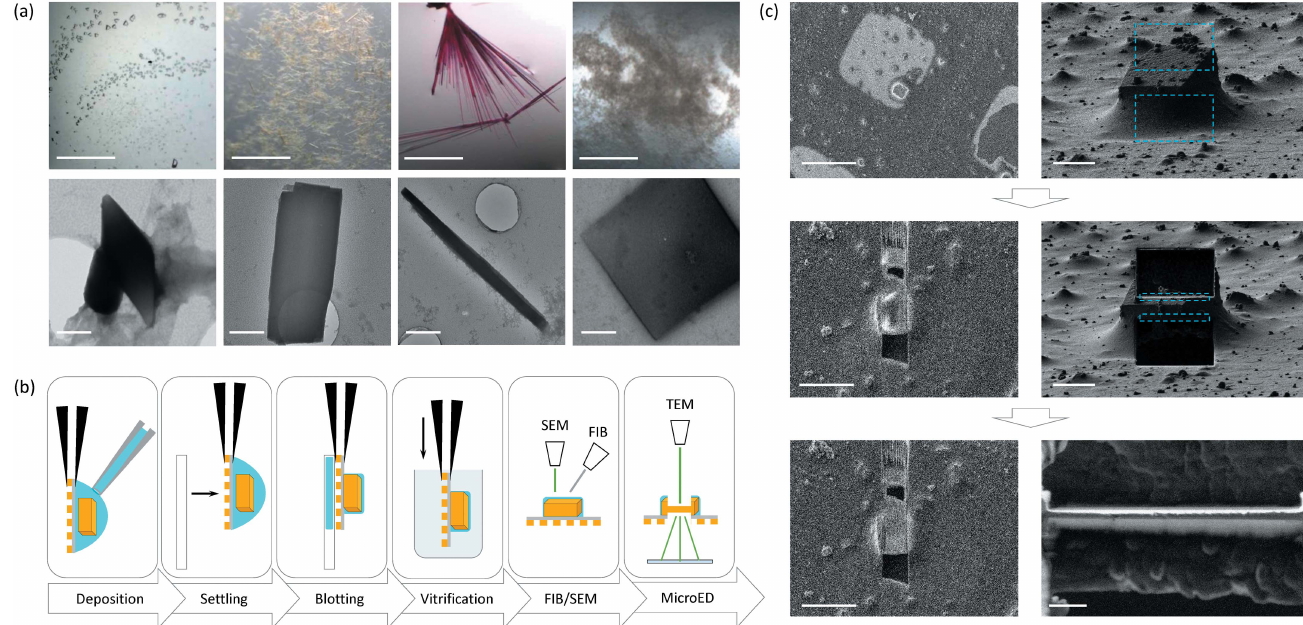
Figure 3 Sample preparation for macromolecular MicroED. ( a ) Several examples of crystallization conditions with protein microcrystals of different morphologies suitable for MicroED. Crystals can be identified using light microscopy as shown in the top row, corresponding images of negatively stained samples are shown on the bottom row. Scale bars for the top row are 500 nm and bottom row 400 nm. Images were adapted from the work by Shi et al. (2016). ( b ) Typical workflow involved in MicroED sample preparation for protein crystals. The crystals are pipetted from the crystallization drop and deposited onto the carbon-side of a glow-discharged EM-grid held between the tips of a tweezer. The crystals are allowed to settle on the grid before any excess liquid is blotted away from the back-side of the grid with filter paper. The grid is then rapidly plunged into liquid ethane for freezing and kept at cryogenic temperatures until use. The grid is either transferred directly to the TEM for MicroED data collection, or can be thinned by cryo-FIB milling into crystalline lamellae suitable for MicroED. ( c ) FIB milling of tetragonal lysozyme crystals, showing the SEM images (left) side by side with the FIB images (right) during a typical milling workflow as described previously by Martynowycz & Gonen (2021 a ). After a suitable crystal is identified, rectangular boxes (blue) are drawn for coarse milling the bulk material (top). The resulting 3 m m-thick lamella is then further thinned by polishing using a lower current and smaller step sizes (middle). This results in a thin crystalline lamella of ideally 200–300 nm thickness and a width of 5 m m (bottom). Scale bars for the SEM images from top to bottom are 50, 25 and 25 m m, for the FIB images from top to bottom 10, 10 and 1 m